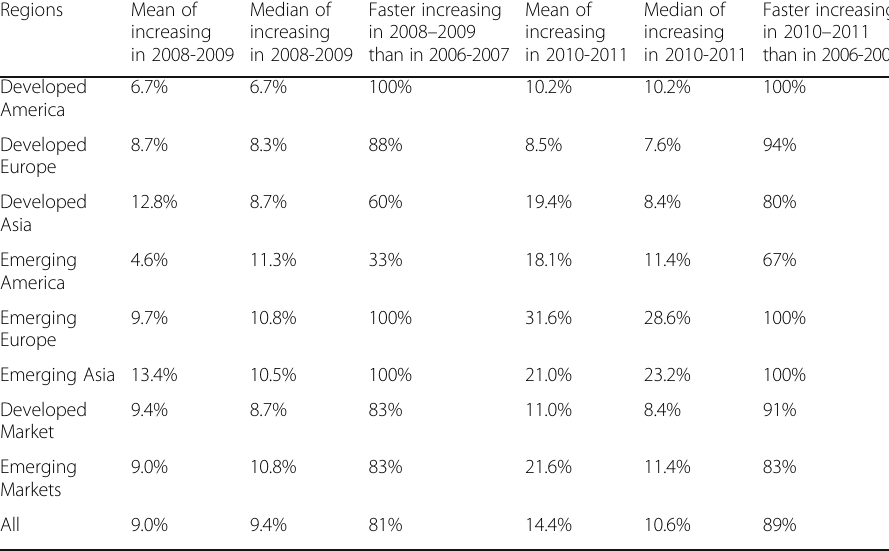
Table 7 Increasing Ratios of sovereign debts in the two crises